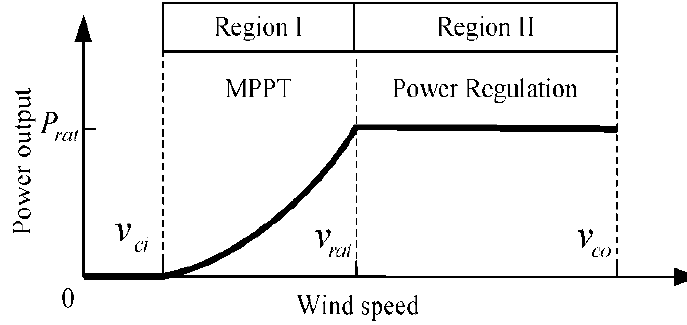
Figure 3. Ideal power curve in wind turbines with varying wind speeds.